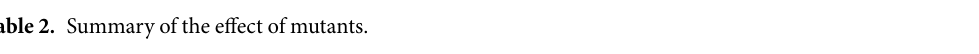
residues at the E2 domain abolished adhesive function of Cx50, which implies the possible interaction between extracellular positively charged residues of Cx50 and negatively charged lipid bilayers. Further investigation in this area is warranted. There are two extracellular loop domains (E1 and E2) of connexin molecules with the E1 domain involved in the formation of the gap junction channel and E2 in the docking compatibility in heterotypic gap junction channels (see review ref. 33). Deletion of either extracellular domain impairs protein stability and intracellular